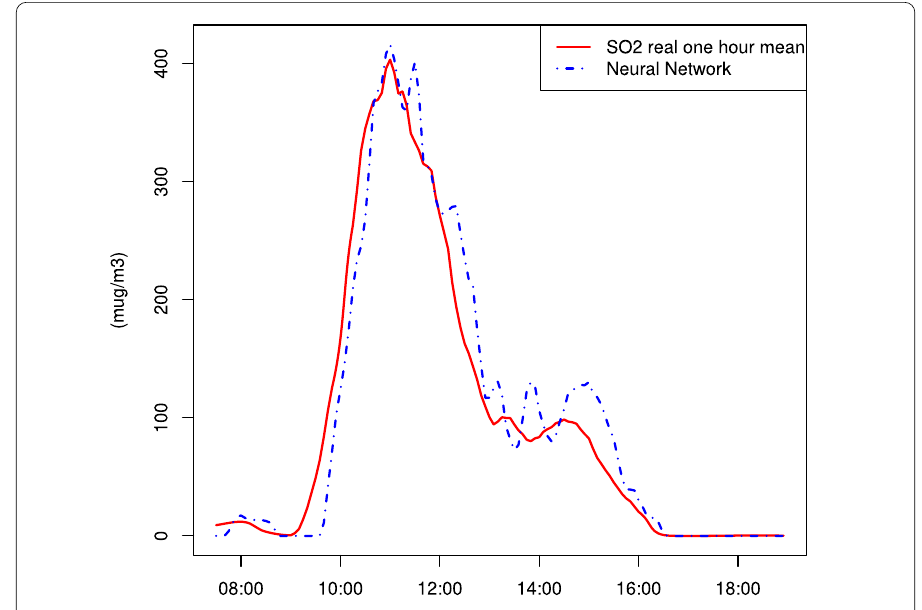
Figure 2 Episode of SO 2 depicted in one of sampling stations (red) jointly with the prediction provided by the neural network (blue) (Fernández de Castro et al. [6])